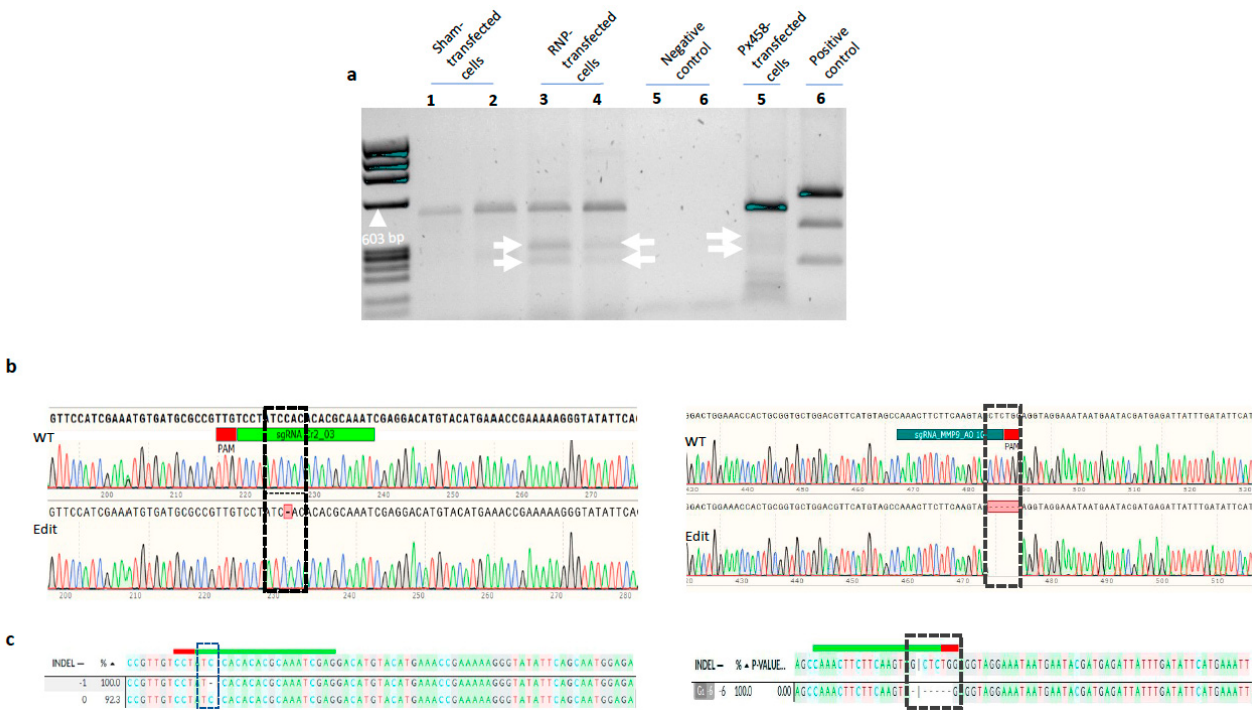
Figure 3. Analyses of mutations in the target regions of cr2 and mmp9 genes due to the applied CRISPR/Cas9 strategies. ( a ) T7E1 assay of the cr2 RNP-transfected CHSE-214 cells. Cleaved frag- ments corresponding to T7 endonuclease 1 digestion of gDNA extract from the RNP-transfected cells are indicated with white arrows in lanes 3 and 4. Similar results were obtained in RNP-transfected ASK-1 and SHK-1 cells for both cr2 and mmp9 . ( b ) Representative Sanger sequencing chromatogram for the target region of cr2 (upper left) and mmp9 (upper right) in ASK-1 cells, either wild-type (WT) or edited with CRISPR/Cas9. The binding regions are represented by the sgRNA rectangular bar, and the edited regions are boxed in dashed lines. ( c ) Representative output of DECODRE analysis of a cr2 RNP-transfected- (lower left) and an mmp9 RNP-transfected (lower right) ASK-1 cell. Indel type and editing frequency are indicated, as well as the aligned sequences of the wild-type and edited samples. The sgRNA including the PAM sequences (red and green bar) highlights the exact target sequence and Cas9 cut site. Boxed dashed lines indicate the exact site of the observed indel mutations.